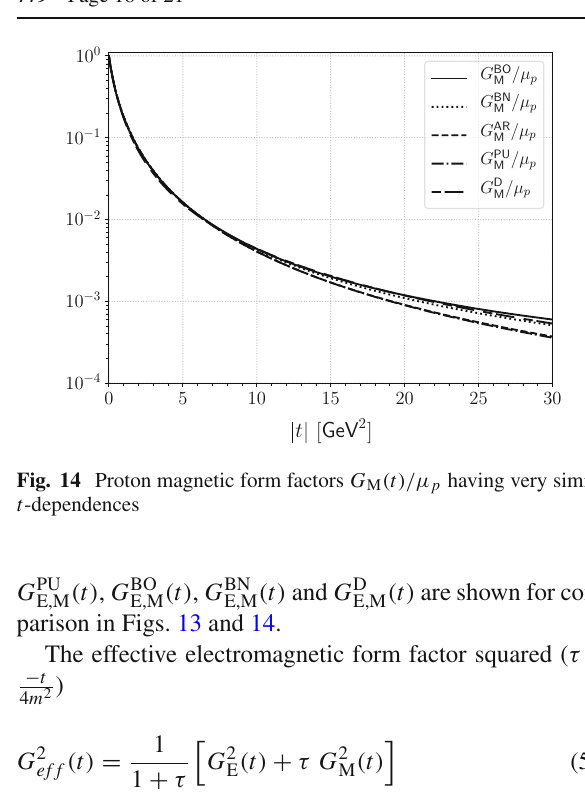
( t ) are shown for com- E,M